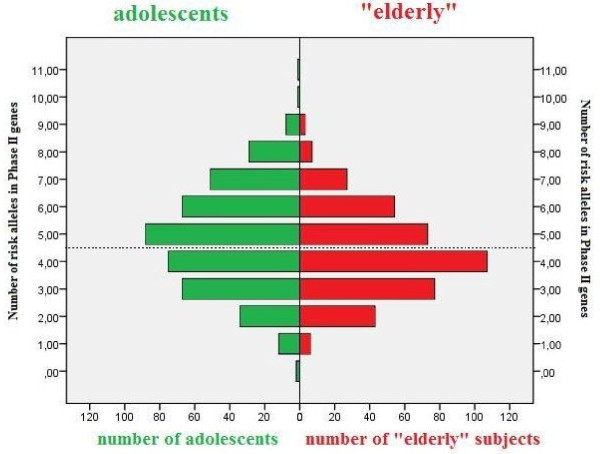
Numbers of risk alleles in Phase II genes among the adolescents and the 'elderly'. The dashed line represents the cut-off point between the relatively low (≤ 4) and high (> 4) sum of risk alleles (see methods). Compared to the adolescents there are less "elderly" persons with five to eleven risk alleles in phase II genes (p < 0.001). Moreover, the mean number of risk alleles is significantly lower in the 'elderly' population compared to the adolescent population (P < 0.001). As can be seen from the figure, among the "elderly" the group with 4 at risk alleles counts the most subjects, more then hundred (107), whereas among the adolescents the group with 5 at risk alleles counts the most subjects, almost 90 (88).